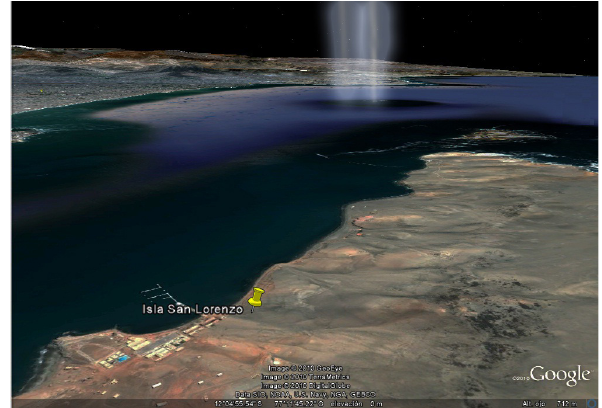
Fig. 5. Position and orientation of the security camera at the PUCP campus, looking west. In the background is the Pacific Ocean and San Lorenzo Island. An eyewitness described the luminescence he observed from the island, as coming out of the ocean, in a southeast direction, towards the